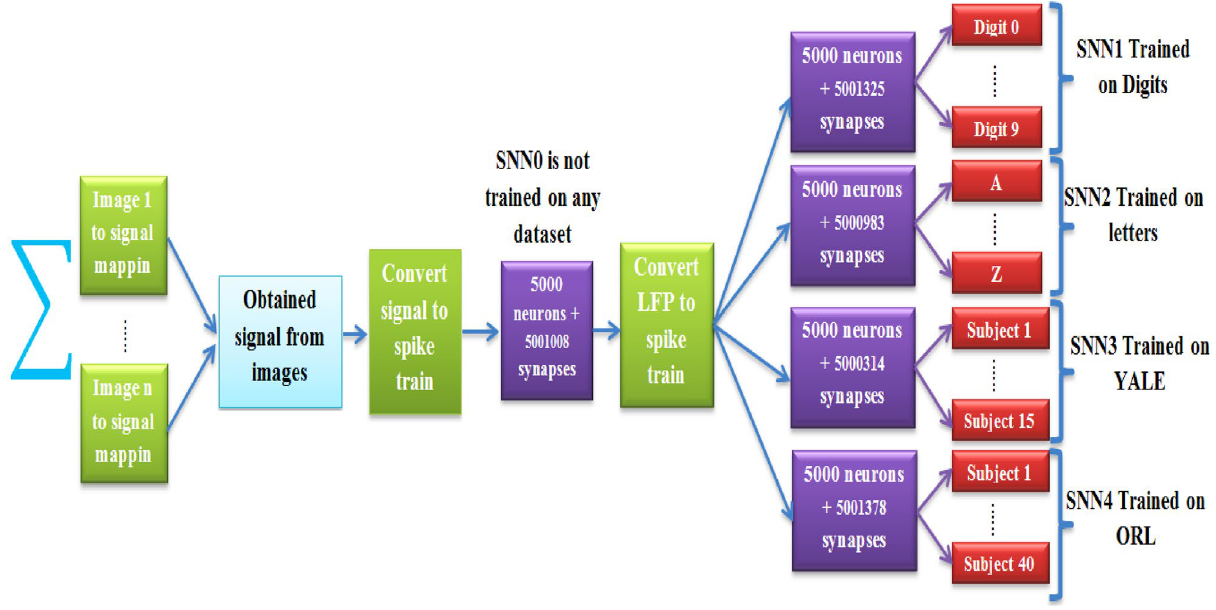
Figure 8. The proposed system configuration for identifying the intertwined patterns, which is based on the interaction of four spiking pattern recognition platforms of sections "Architecture and learning mechanism of the pattern recognition network based on SNN1 (digit recognition)" and "Pattern recognition networks based on SNN2, SNN3, and